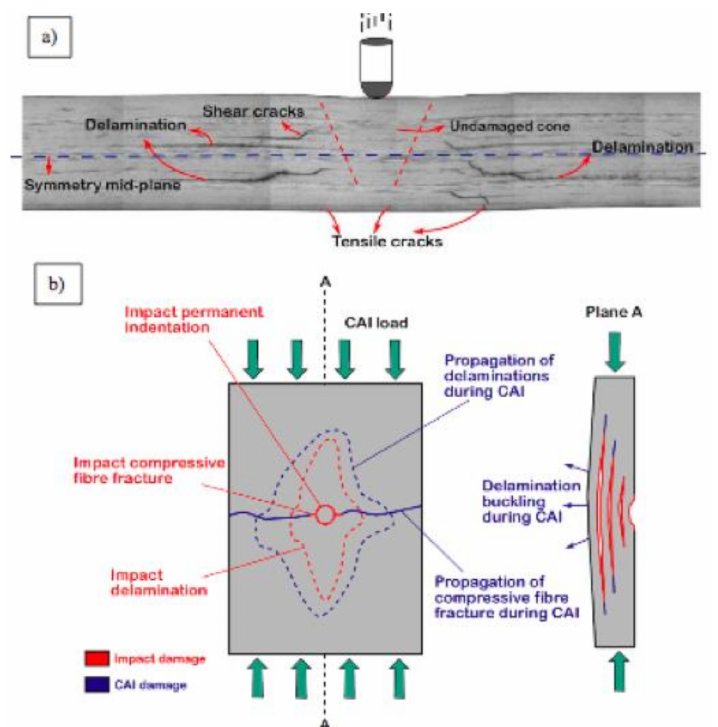
Figure 3. Impact damage and loss of compressive strength, (reproduced with permission from [43]). Legend Compression After Impact (CAI). ( a ) Internal damages caused inside a laminate by the impact of a foreign object ( b ) Loss of compressive strength as a consequence of these damages.